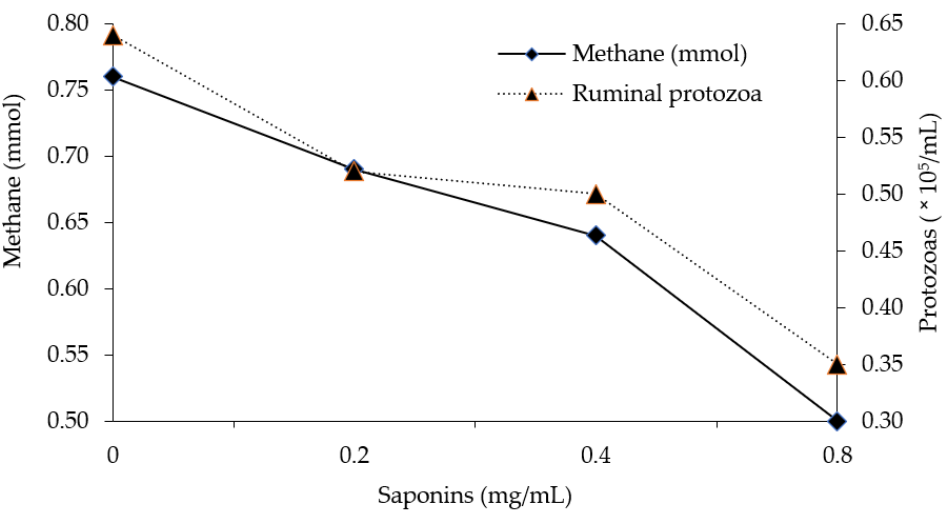
Figure 1. Effect of the inclusion of saponins on protozoa population and rumen methane (CH 4 ) in vitro (Adapted from Hu et al., 2006 [70]).